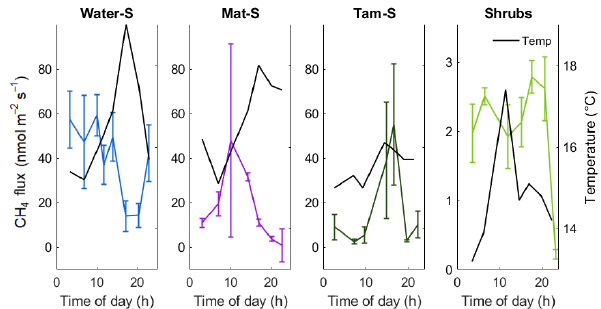
Figure 5. Plant-mediated CH 4 fluxes from loosestrife leaves (Mat zone), tamarack leaves, tamarack Stems, and blueberry leaves (Tamarack and Shrubs zone). Only fluxes from the blueberry were significantly different from zero ( p = 0 .